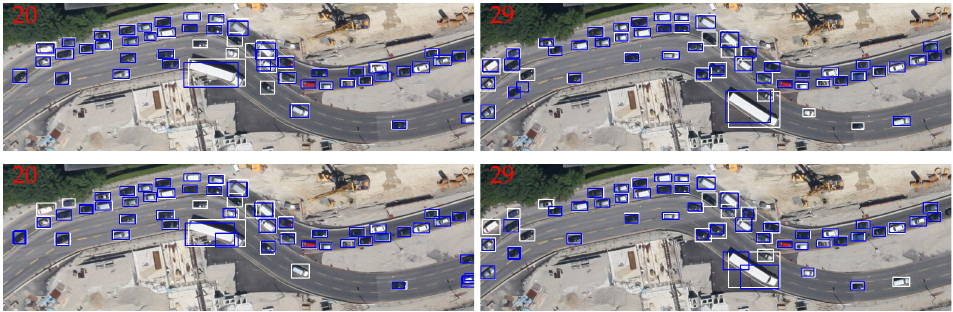
Figure 20. Tracking results by AerialMPTNet ( top row ) and SMSOT-CNN ( bottom row ) on the frames 20 and 29 of the “MunichStreet04” sequence of the KIT AIS vehicle dataset. The predictions and ground truth bounding boxes are depicted in blue and white,